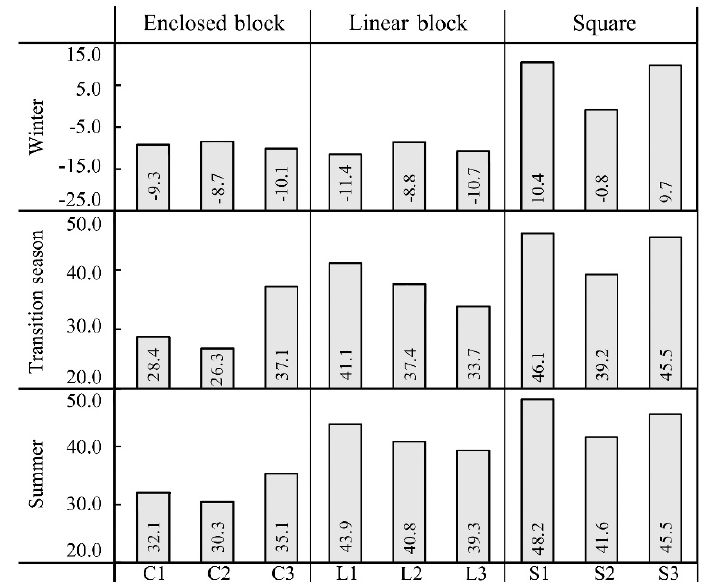
Figure 10. Average mean radiation temperature ( ℃ ) of each measurement point in different seasons.